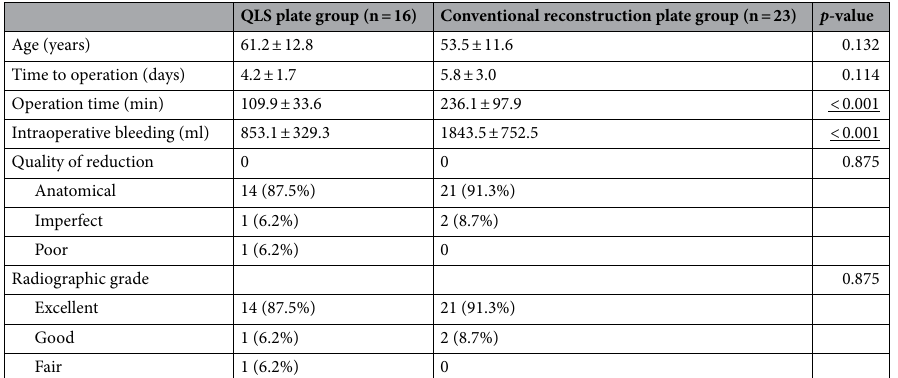
Table 5. Comparison between the QLS plate and conventional reconstruction plate groups. QLS: quadrilateral surface, Continuous variables are presented as mean ± standard deviation.